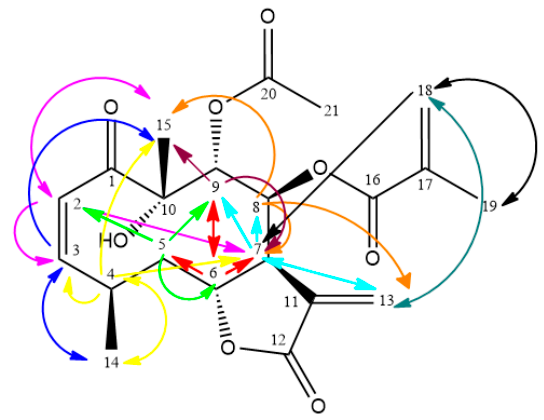
Figure 2. NMR NOESY correlations of 1 .